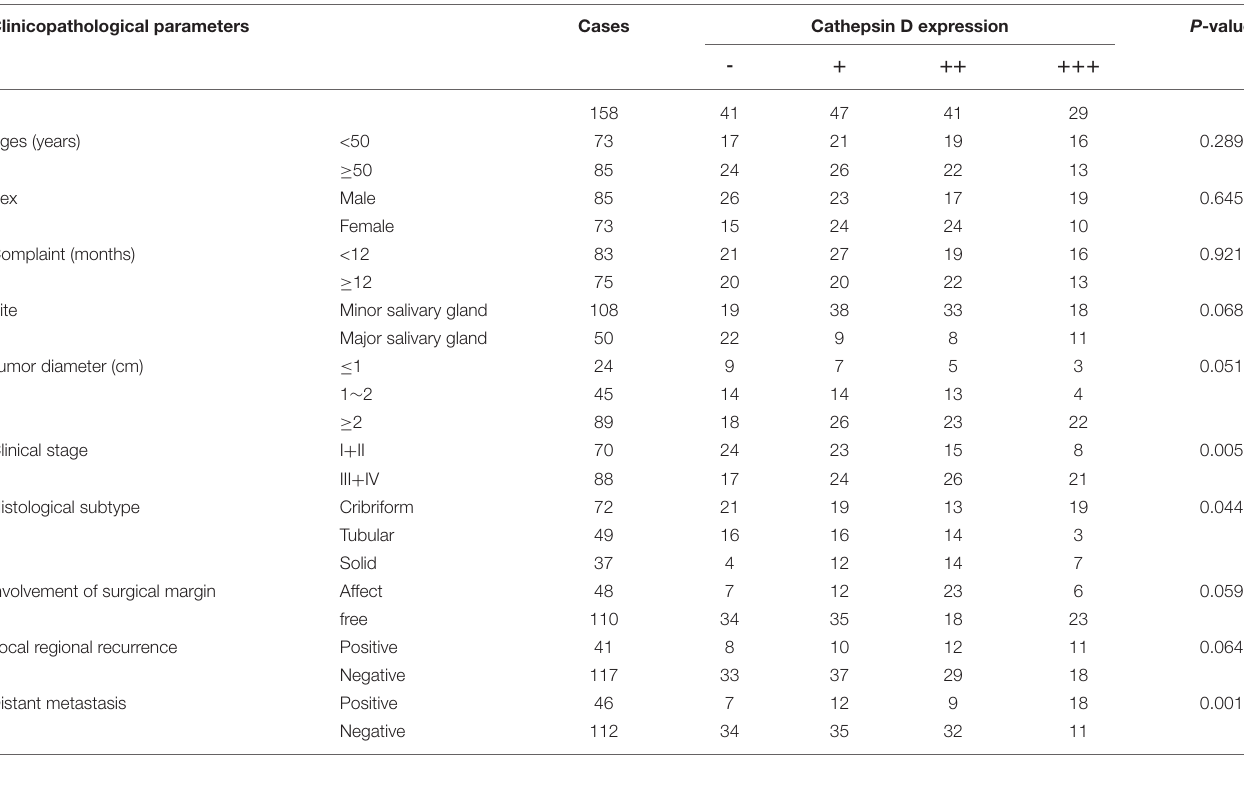
TABLE 2 | Correlation between Cathepsin D expression and clinicopathological parameters in salivary adenoid cystic carcinoma. Clinicopathological parameters